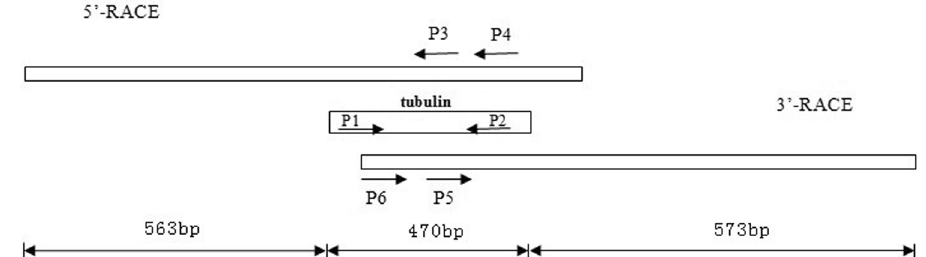
Figure 7. Principle of primer designed for coloning the β - tubulin gene from S. chinensis .